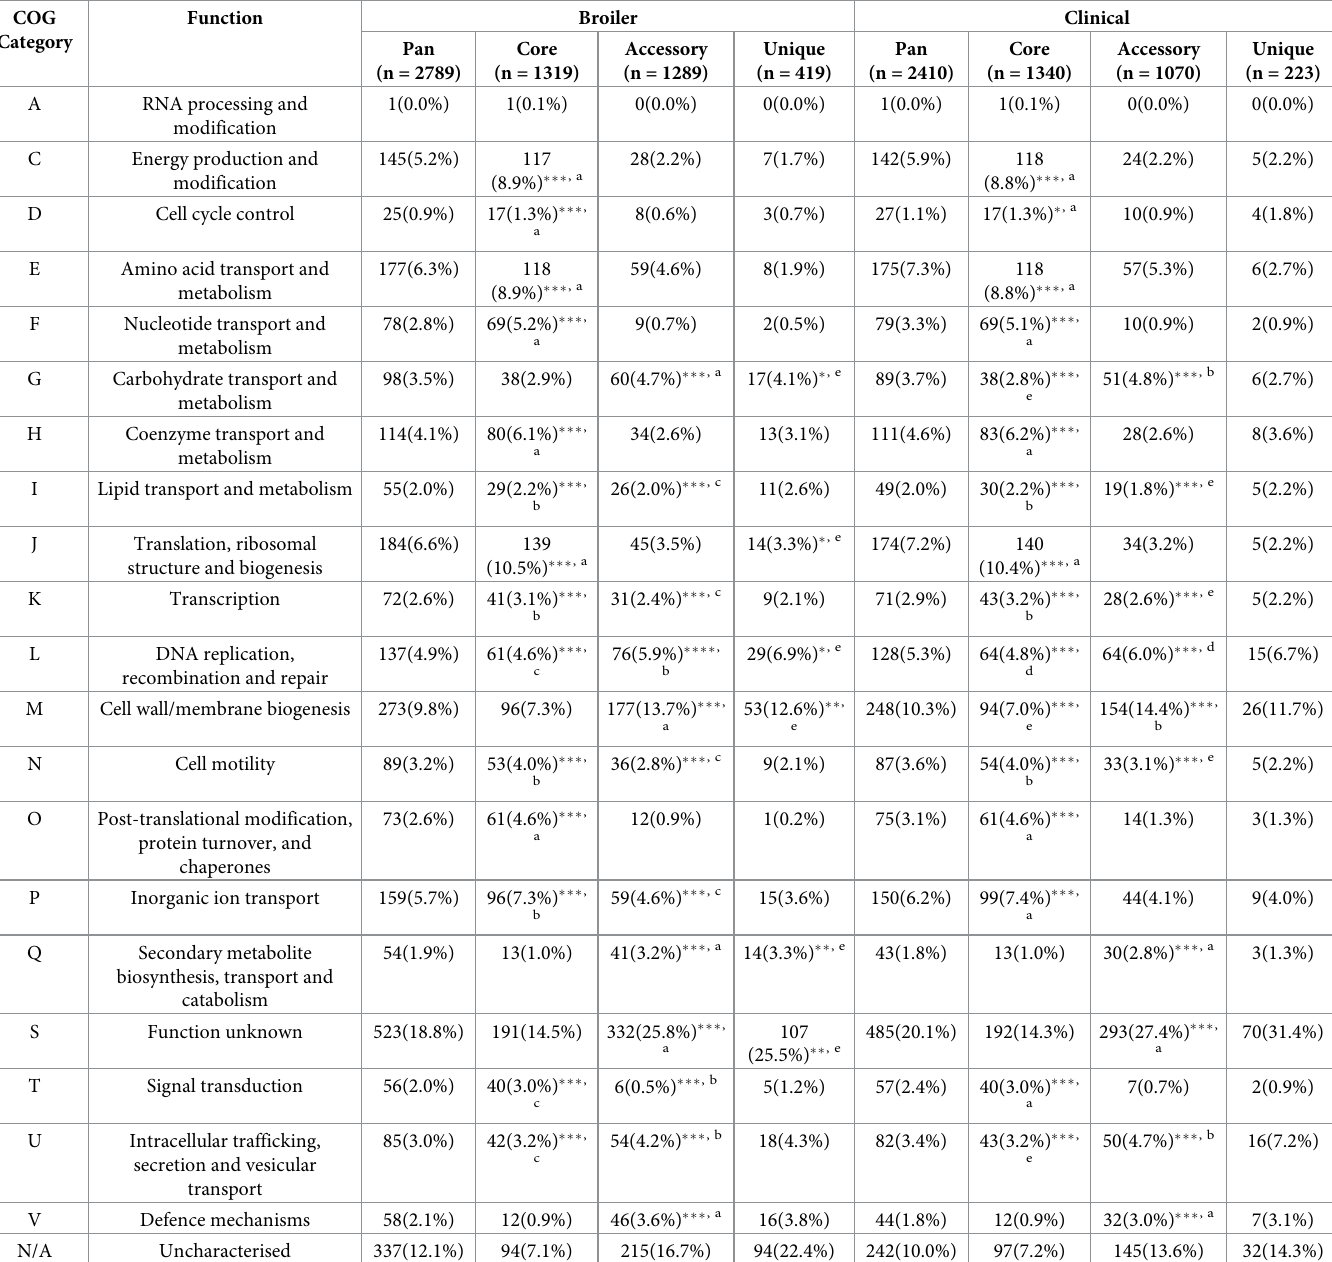
Table 2. Functional annotation of the pan, core and accessory genomes and of genes unique to clinical and broiler C . jejuni